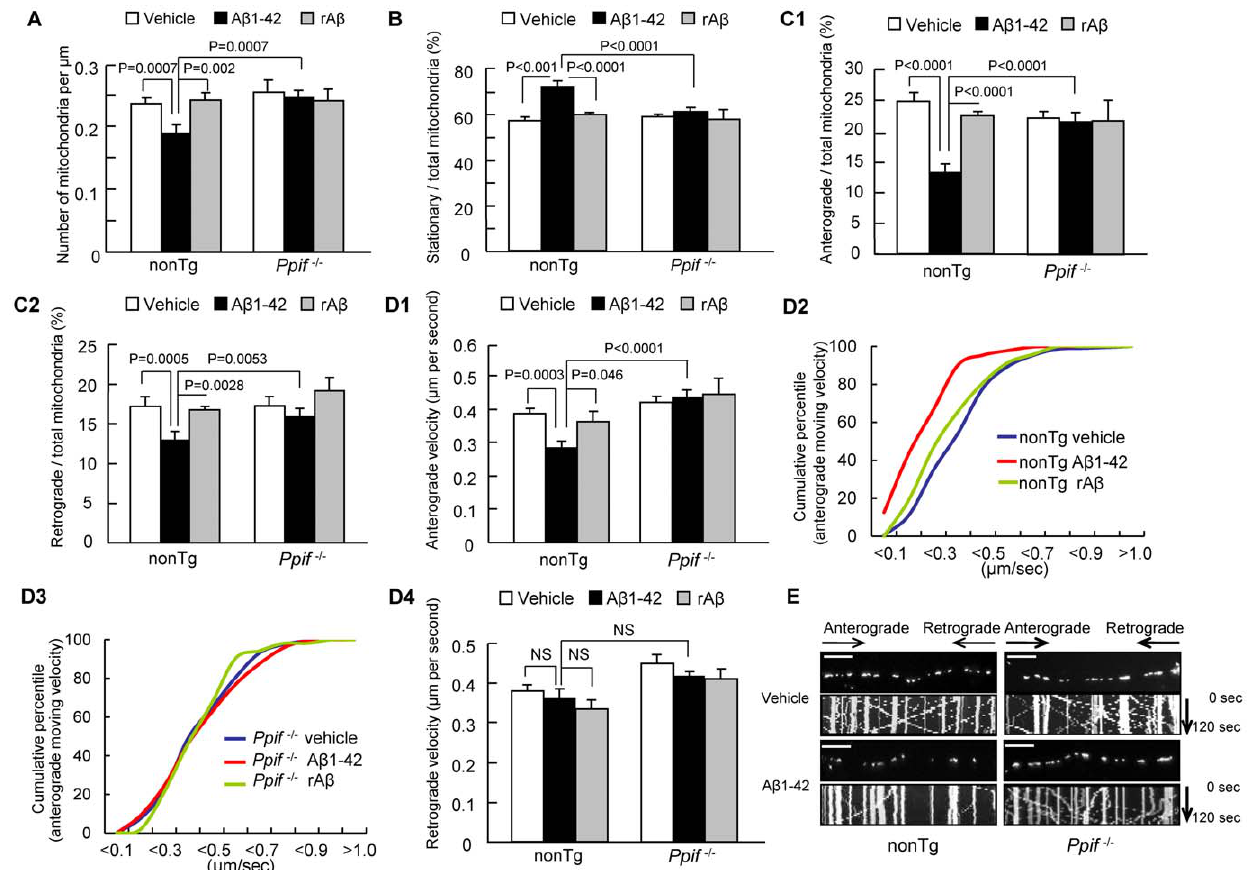
Figure 1. Loss of CypD protects axonal mitochondrial motility and dynamics from A b toxicity. ( A ) CypD depletion increased axonal mitochondrial density (numbers per micron of axon) in A b -treated neurons. rA b : reversed A b 42-1. There is no significant difference in the axonal mitochondrial density between vehicle-treated nonTg and Ppif 2 / 2 neurons. Data were collected from 3 independent experiments. ( B ) CypD depletion decreased the percentage of stationary mitochondria in A b -treated neurons. There were no significant changes in the percentage of stationary mitochondria between vehicle-treated nonTg and Ppif 2 / 2 neurons. Data were collected from 1380, 1074, 1410 mitochondria from vehicle, A b and rA b groups in nonTg neurons, and 1634, 1505, 642 mitochondria in Ppif 2 / 2 neurons, respectively, in 4 independent experiments. ( C ) CypD depletion restored the decrease in the percentage of anterograde mitochondria ( C1 ) and retrograde mitochondria ( C2 ) in A b -treated neurons. Data were collected from 4 independent experiments. ( D ) CypD depletion increased the velocity of mitochondrial movement. ( D1 ) A b treatment deceased the velocity of anterograde movement of nonTg mitochondria but not in CypD-deficient ( Ppif 2 / 2 ) mitochondria. Data were collected from 209, 141, 46 mitochondria from vehicle, A b and rA b groups in nonTg neurons, and 158, 209, 52 mitochondria in Ppif 2 / 2 neurons. ( D2–3 ) The cumulative distribution data showed a left shift of the velocity of anterograde mitochondria when comparing the curve for A b -treated nonTg mitochondrial to Ppif 2 / 2 mitochondria. Data were collected from 3 independent experiments, respectively. ( D4 ) A b treatment had no effect on the velocity of the retrograde mitochondria from both nonTg and Ppif 2 / 2 mice. ( E ) CypD depletion rescued axonal mitochondrial mobility. Images in the top portion of the panel and kymographs in the lower panel were generated from the live imaging movies. In the kymographs, the X axis represents the mitochondrial position and the Y axis is time. Vertical white lines represent stationary mitochondria and diagonal lines represent moving mitochondria. Anterograde movements are from left to right, retrograde movements are reversed. Scale bars represent 10 m m. vehicle groups ( Fig. 2A vehicle: 1.483 6 0.071 vs. A b : 1.256 6 0.043 m m), the average length of A b superimposed Ppif 2 / 2 mitochondria was better preserved than that of A b -treated nonTg mitochondria ( Fig. 2A–C; Ppif 2 / 2 :1.256 6 0.043 m m vs. nonTg: 0.933 6 0.037 m m). No significant difference was found in an average length when comparing vehicle-treated nonTg to Ppif 2 / 2 axonal mitochondria ( Fig. 2A ). The rA b as a control did not alter axonal mitochondrial length ( Fig. 2A–C ). These results suggest that A b toxicity leads to increased axonal mitochondrial fragmentation and importantly, this effect is significantly attenu- ated by CypD depletion.